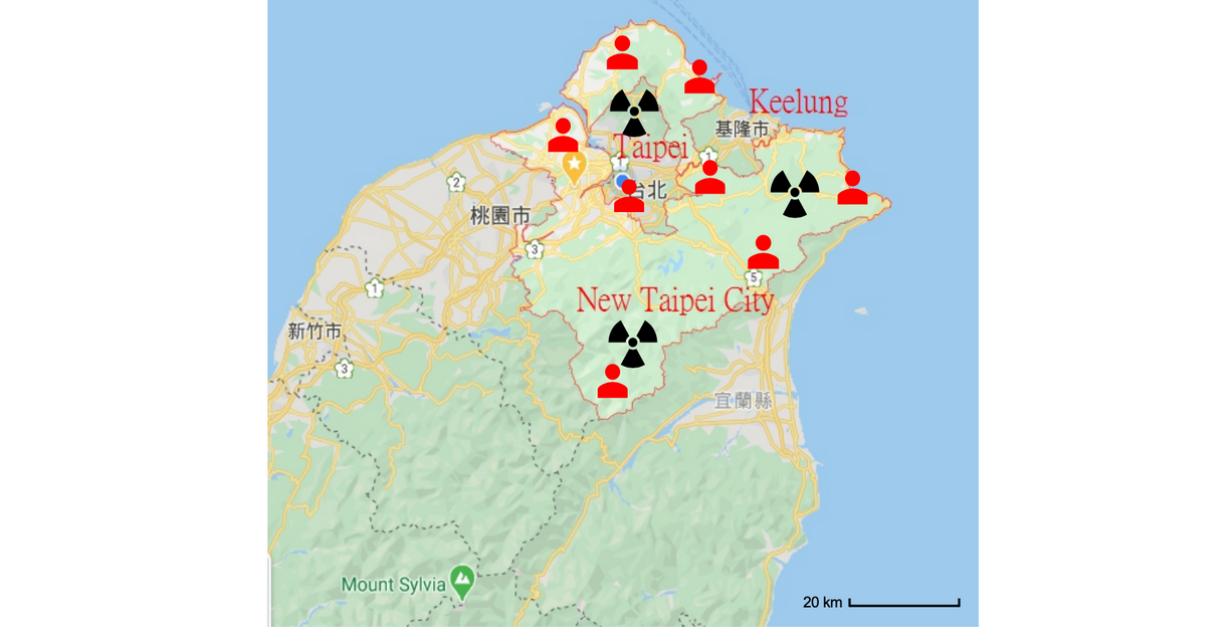
Figure 2. The tagged locations based on routes of passengers in three cities (Keelung, New Taipei City, and Taipei) for broadcasting the warning message. Tagged locations: (1) Keelung: Keelung Waimu Mountain, Keelung Zhongzheng Park, Keelung Cultural Center, Xiandong, Keelung,